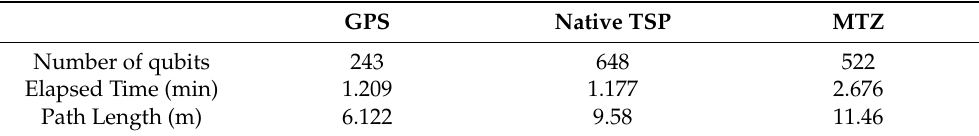
Table 2. A regular polygon layout has been taken where the cities occupy the positions of the nodes [50] for the elaboration of all tables. In this scenario of 6 cities, we set comparison with the 3 models, MTZ, native TSP and GPS. The comparison is based on the number of times to find the solution, the distance travelled, and the number of qubits. We can appreciate the good performance of our GPS model, and above all the savings it offers us in the number of qubits. GPS Native TSP MTZ Number of qubits 147 294 266 Elapsed Time (min) 0.337 0.39 1.338 Path Length (m) 6.00 6.00 8.46 Table 3. A regular polygon layout has been taken where the cities occupy the positions of the nodes [50] for the elaboration of all tables. In this scenario of 8 cities, we set comparison with the 3 models, MTZ, native TSP and GPS. The comparison is based on the number of times to find the solution, the distance travelled, and the number of qubits. We can appreciate the good performance of our GPS model, and above all the savings it offers us in the number of qubits. GPS Native TSP MTZ Number of qubits 243